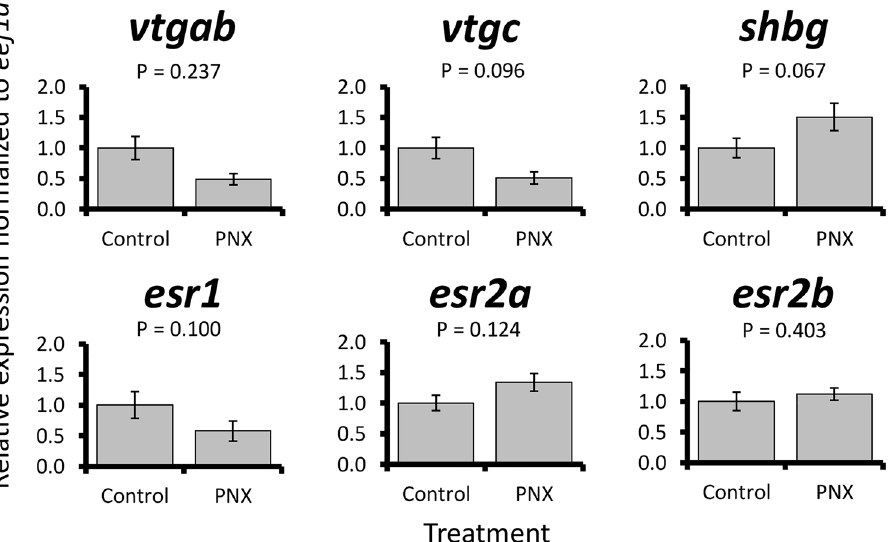
Figure 6. Relative mRNA expression normalized to eef1a of six steroid-associated liver genes ( vtgab , vtgc , shbg, esr1 , esr2a , and esr2b ) in control and PNX-treated puffers. Each bar represents the mean ± standard error, and significance was assessed at P < 0.05.